Question: State the chart type depicted above.
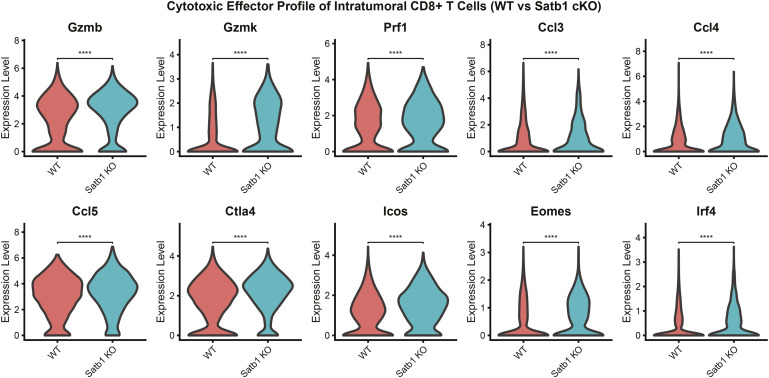
Answer: bar